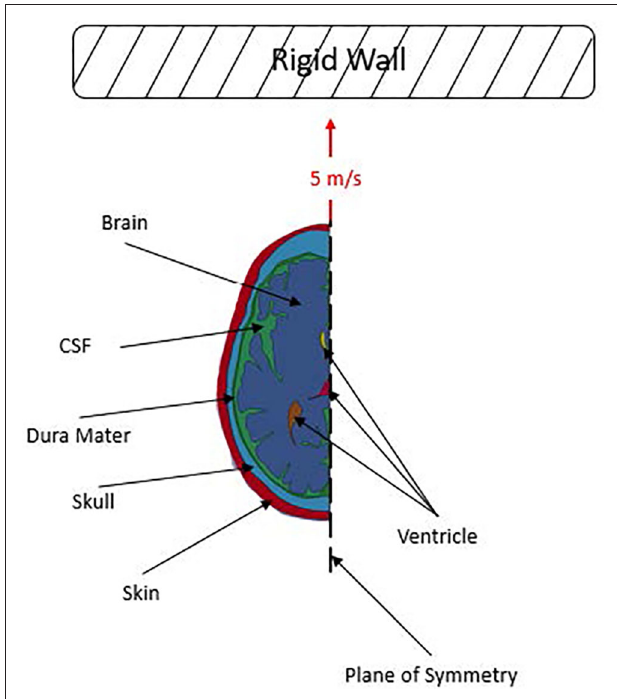
FIGURE 1 | Simulation